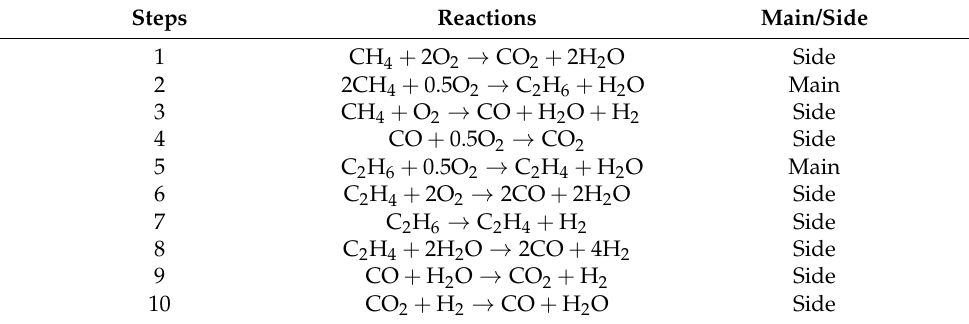
Table 3. The main and side reactions of the OCM process.